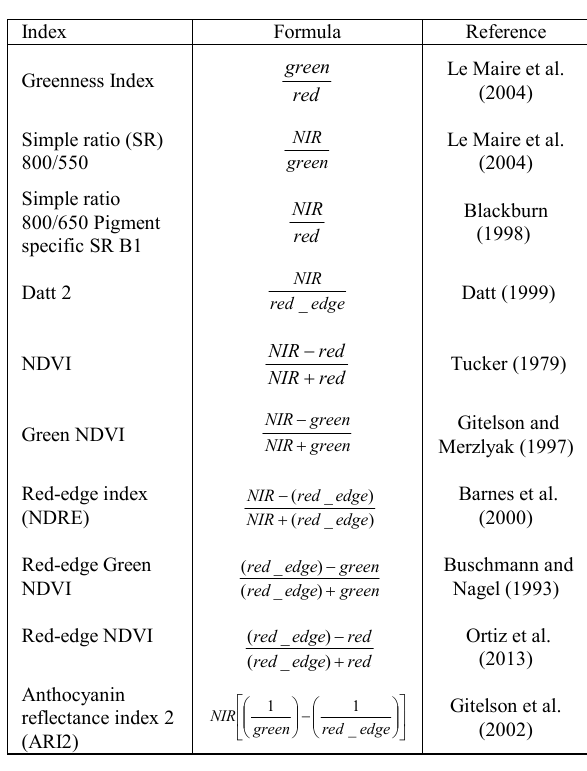
Figure 3. Selected appropriate samples for the spectral response analysis of different disturbance categories.